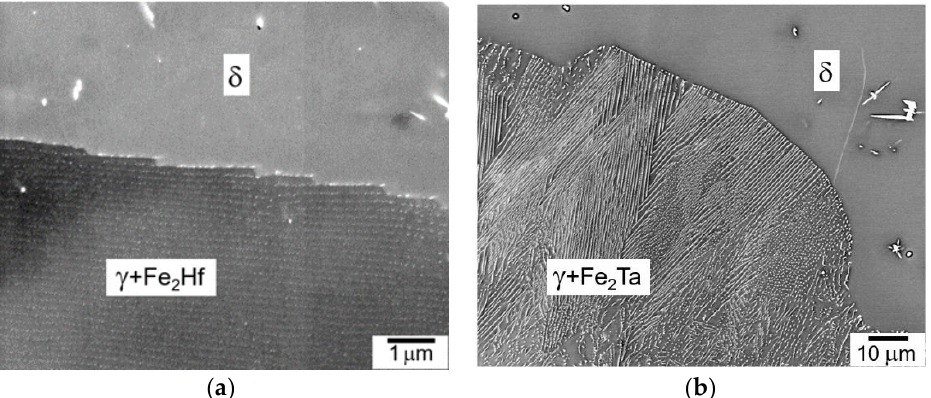
Figure 7. BSE images showing different types of precipitation modes for Fe 2 M phases on the pseudo- eutectoid reaction path: δ → γ + Fe 2 M: ( a ) interphase precipitation observed in the Fe-9.4Cr-0.1Hf alloy water-quenched from 1300 °C, ( b ) fibrous precipitation observed in the Fe-9.7Cr-0.6Ta alloy heat treated at a rate of 0.5 °C/s from 1250 °C . The γ phase in the transformed regions is transformed to α -Fe phase during cooling from high temperatures.